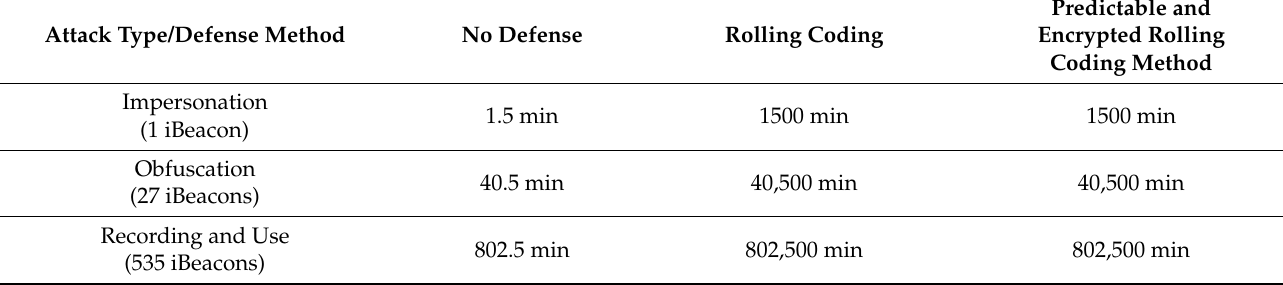
Table 1. iBeacon attack and defense